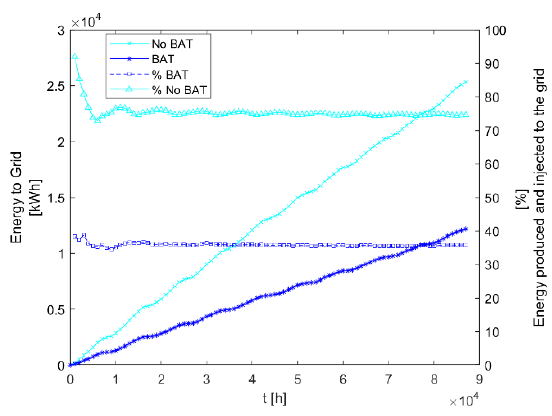
Figure 16. Energy to the grid (Location 1).